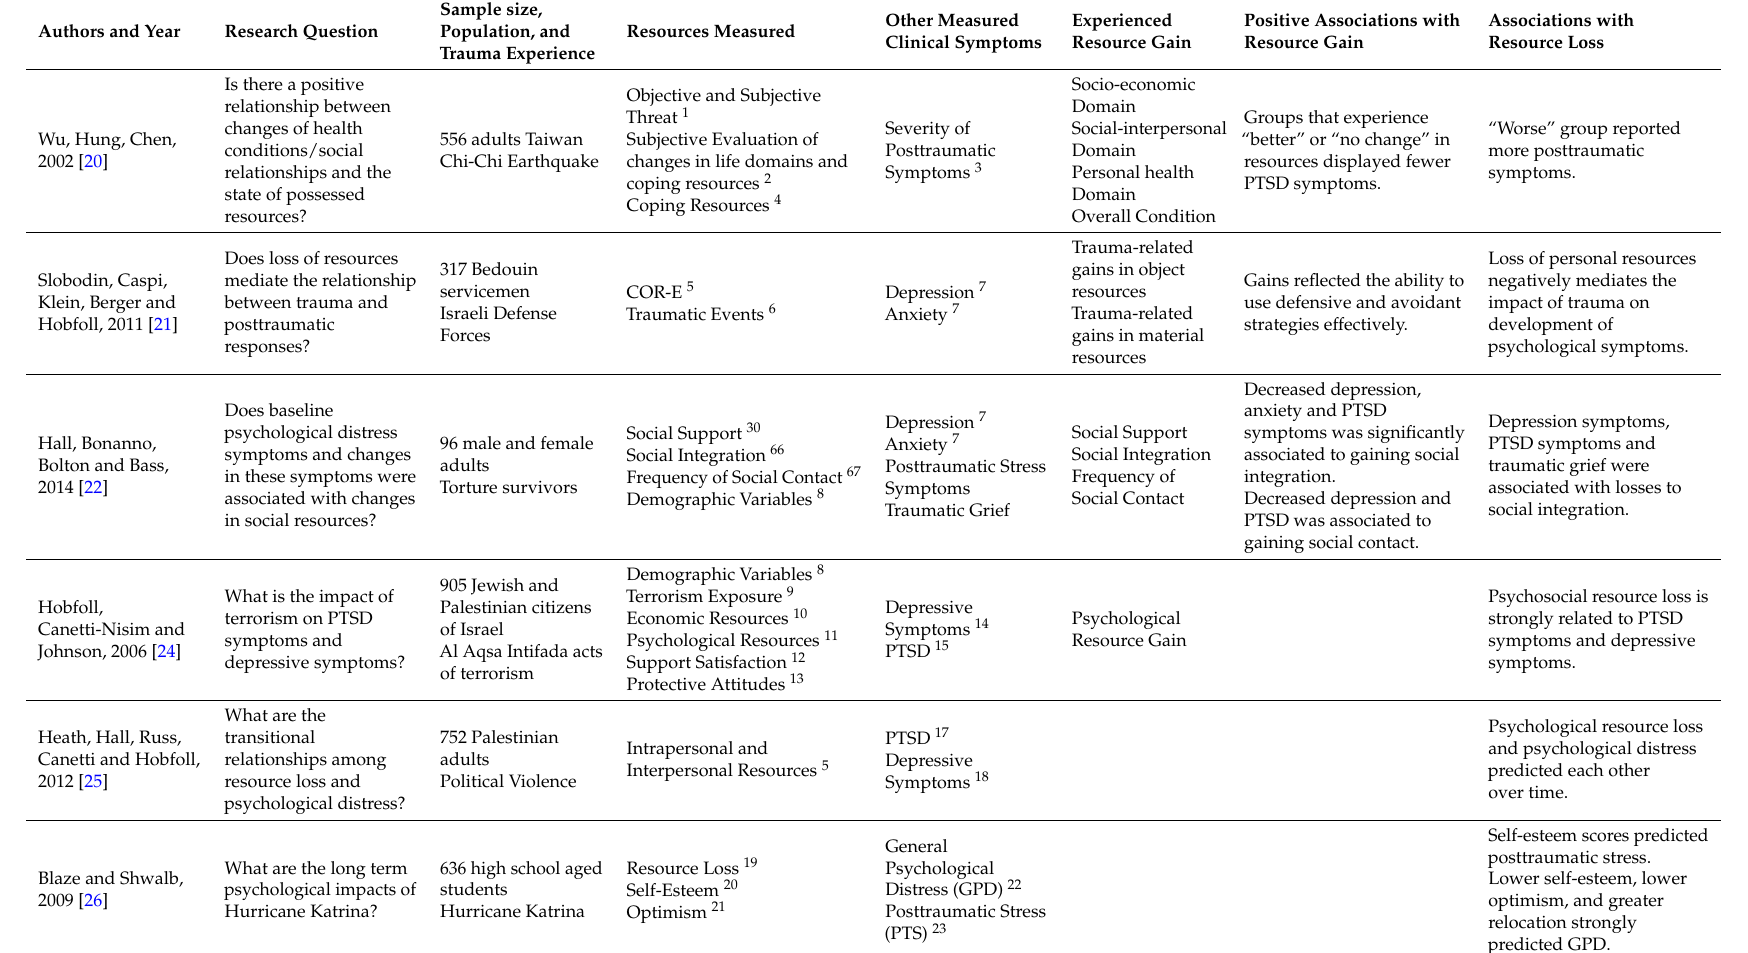
Table 1. Association Studies with a PTSD Focus, Summary